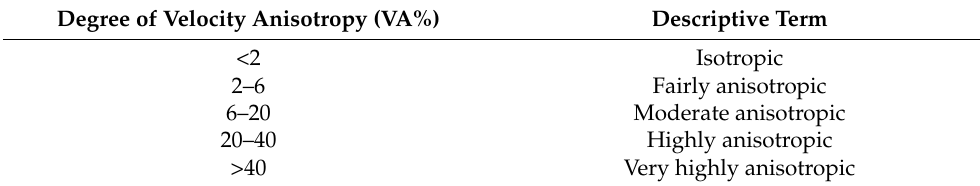
Table 8. Anisotropy classification according to ultrasonic wave velocity [44]. Degree of Velocity Anisotropy (VA%)